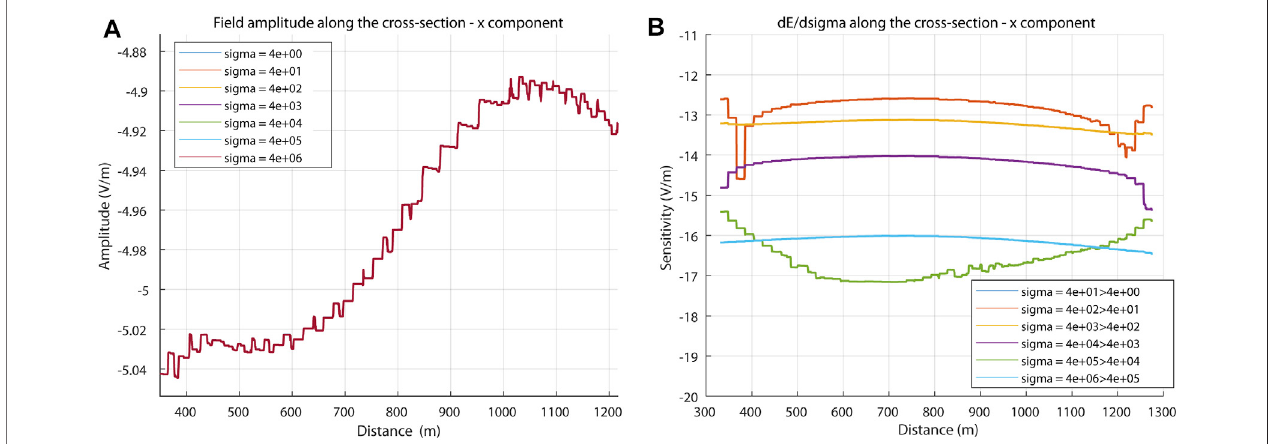
FIGURE8|(A) Electrical fi eldamplitude( x -component)alongthecross-section(whitedashedlinein Figure6A )forthedifferentcorrosionlevelsshownin Figure7 . (B) Derivative of the electrical fi eld ( x -component) with respect to conductivity change along the cutline for different corrosion levels. h =10 m corresponds to the corroded section and sigma corresponds to the conductivity of corroded casing. Logarithmic scale is used for the vertical axis.